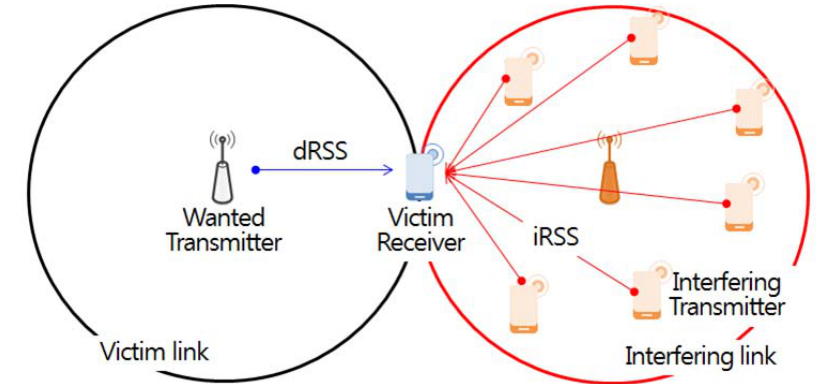
Figure 6. Victim link and interfering